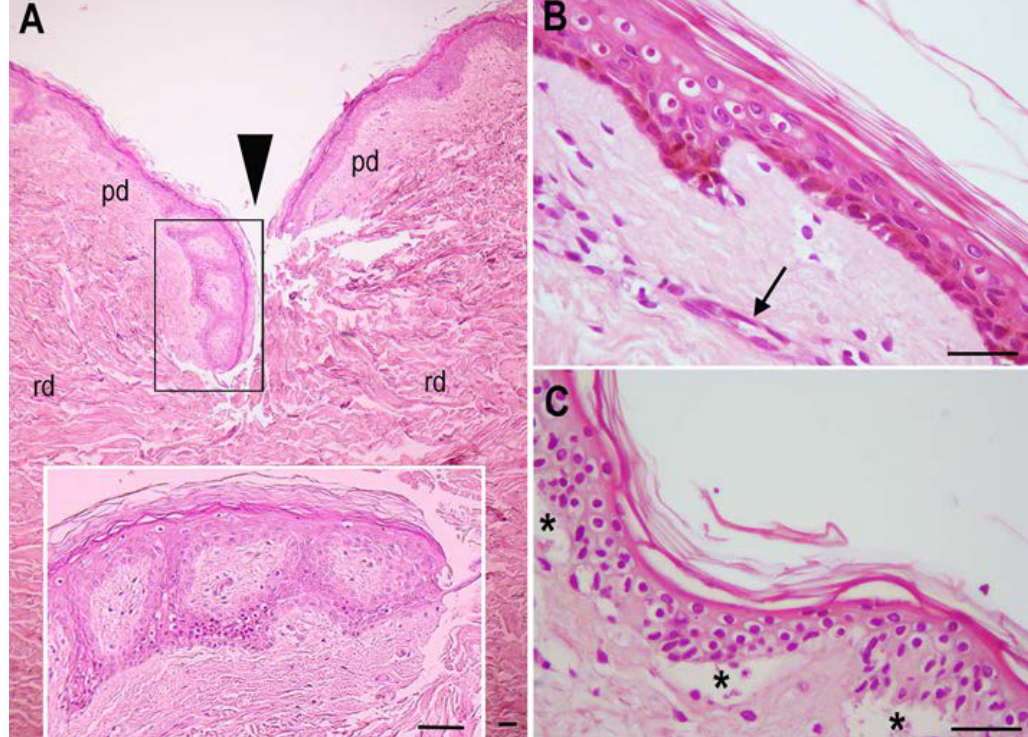
Figure 2. Representative histological features of the skin specimens after long-term incubation, freezing and thawing. ( A ) Transverse section across the surgical wound shows the epidermis nearby with pronounced rete ridges (inset); pd: papillary dermis, rd: reticular dermis. ( B ) High magnification of a skin specimen incubated in enriched medium showing a substantially normal epidermis, with brown melanin pigment in the basal layer and scattered keratinocytes with vacuolated cytoplasms, and preserved blood capillaries (arrow). ( C ) Same magnification of a skin specimen incubated in non-enriched medium showing diffuse keratinocyte vacuolation and detachment of the epidermis from the basement membrane (asterisks). H&E staining; bars = 100 µm .